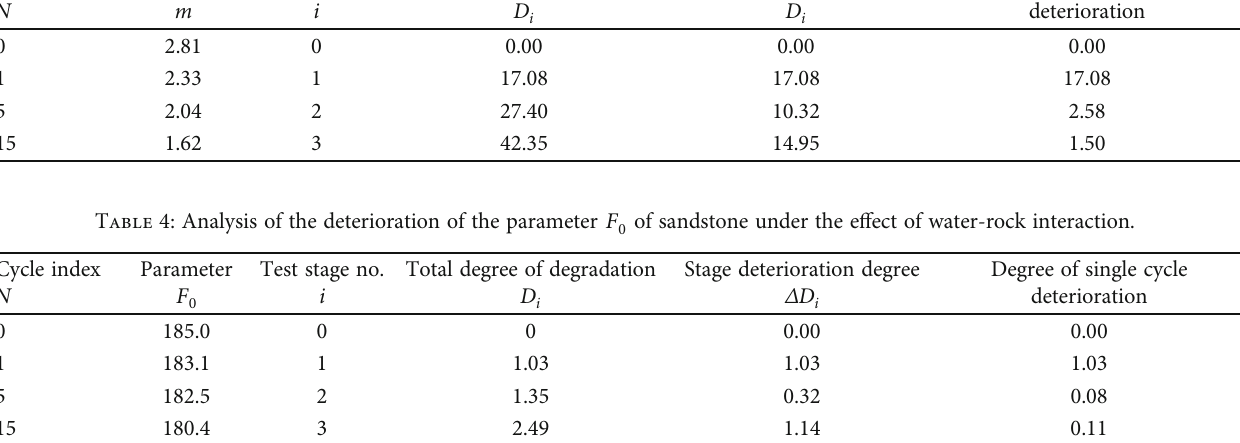
Table 3: Analysis of the deterioration of the parameter m of sandstone under the e ff ect of water-rock interaction. Cycle index Parameter N